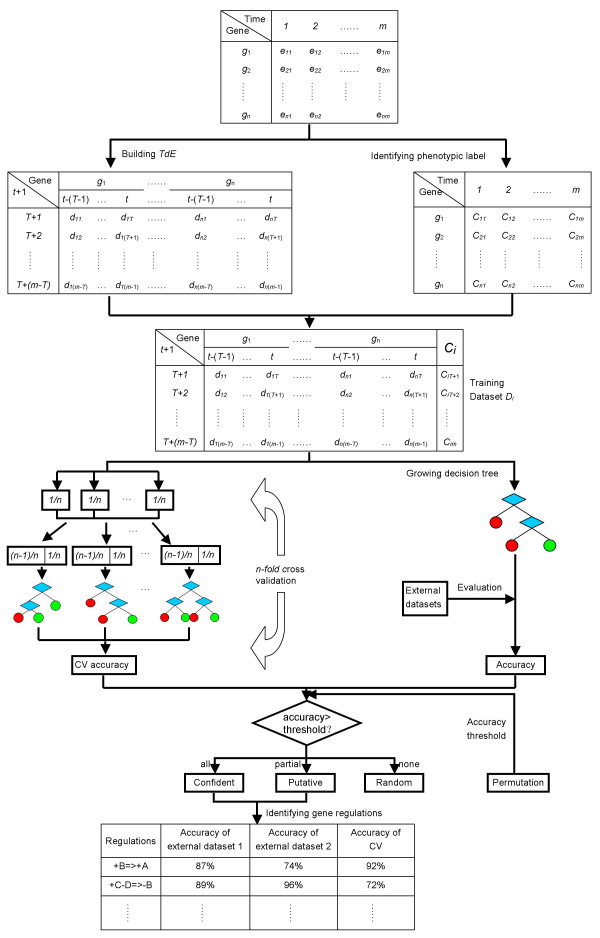
The graphic algorithm flow of the TdGRN method.